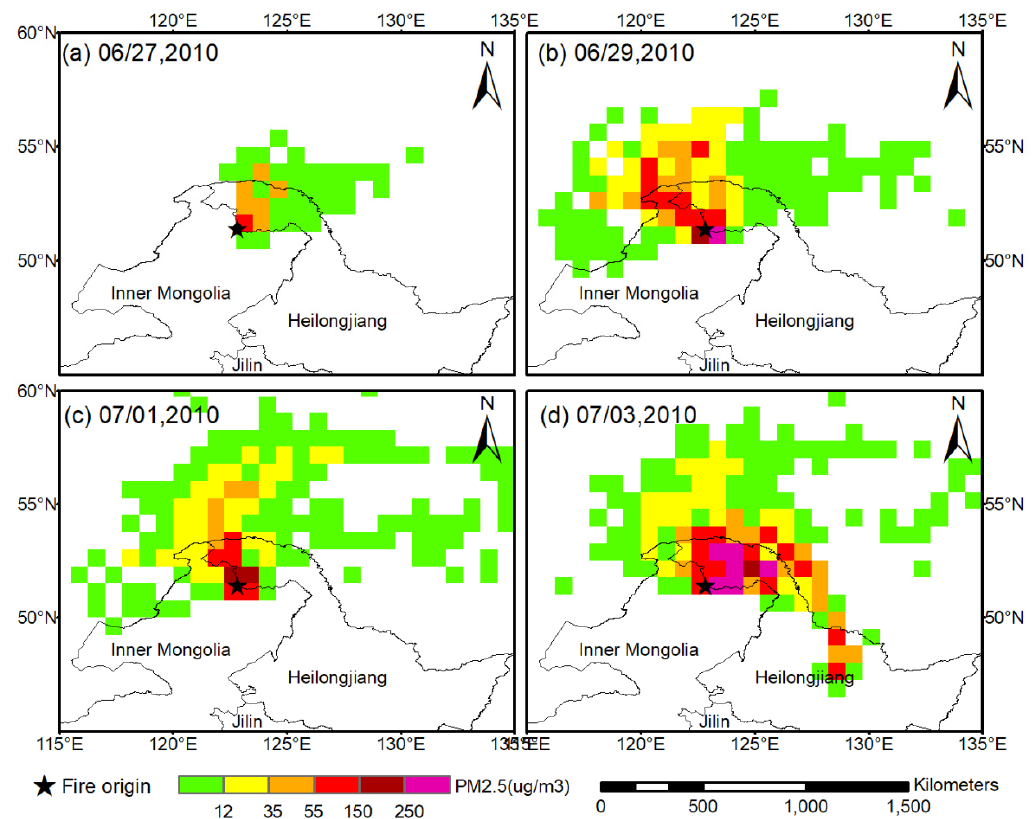
Figure 5. Same as Figure 3 except for the Huzhong fire. Panels ( a – d ) are 27 and 29 June and 1 and 3 July 2010, respectively.